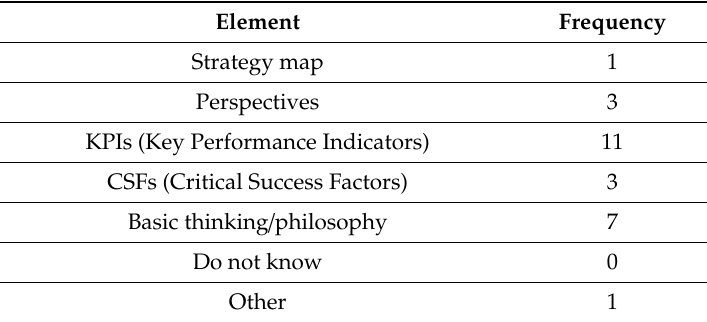
Table 10. Selective use of elements of the BSC (N =